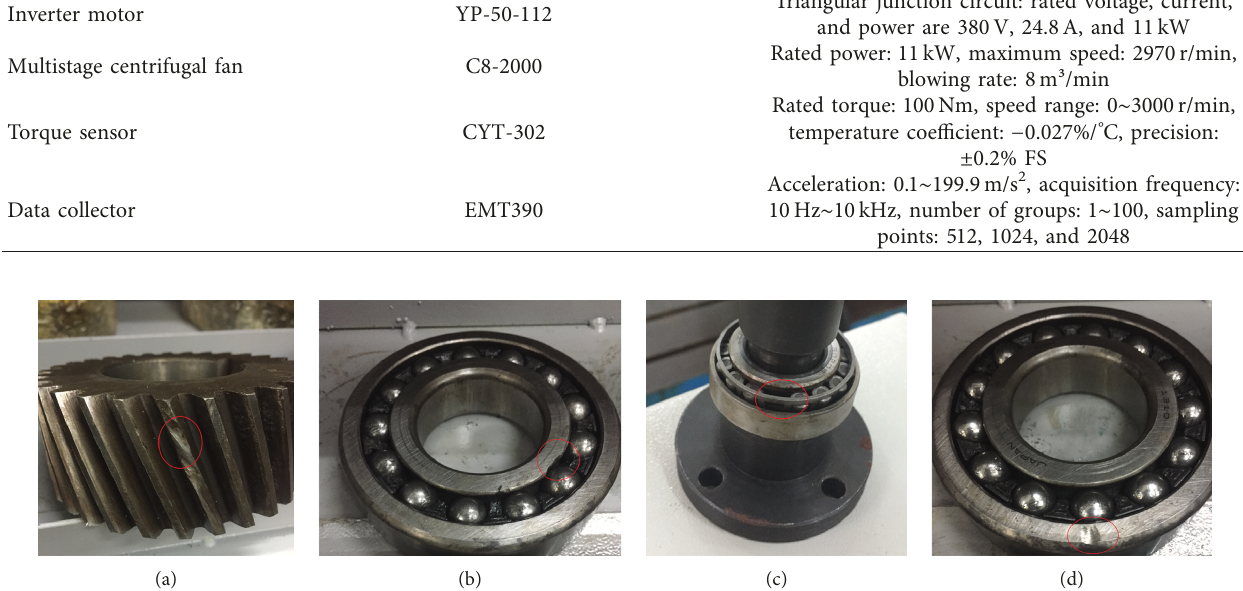
Figure 4: The four fault conditions of rotating machinery: (a) gear teeth missing; (b) bearing inner ring wear; (c) bearing lack of ball bearings; (d) bearing outer ring